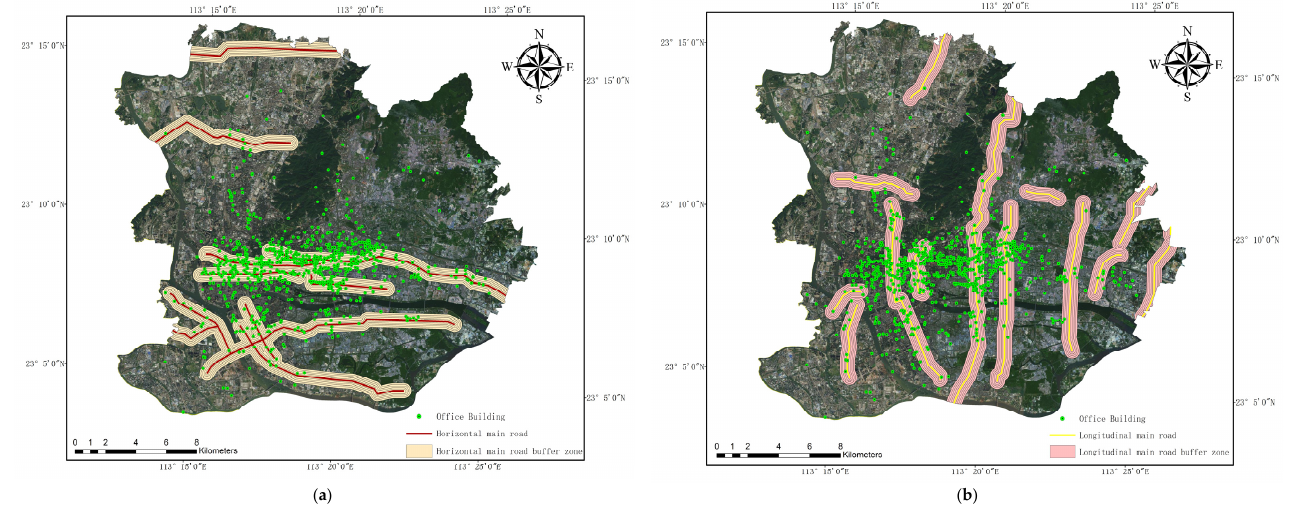
Figure 5. Distribution of trunk road in the inner fringe of Guangzhou: ( a ) horizontal direction trunk road; ( b ) vertical direction trunk